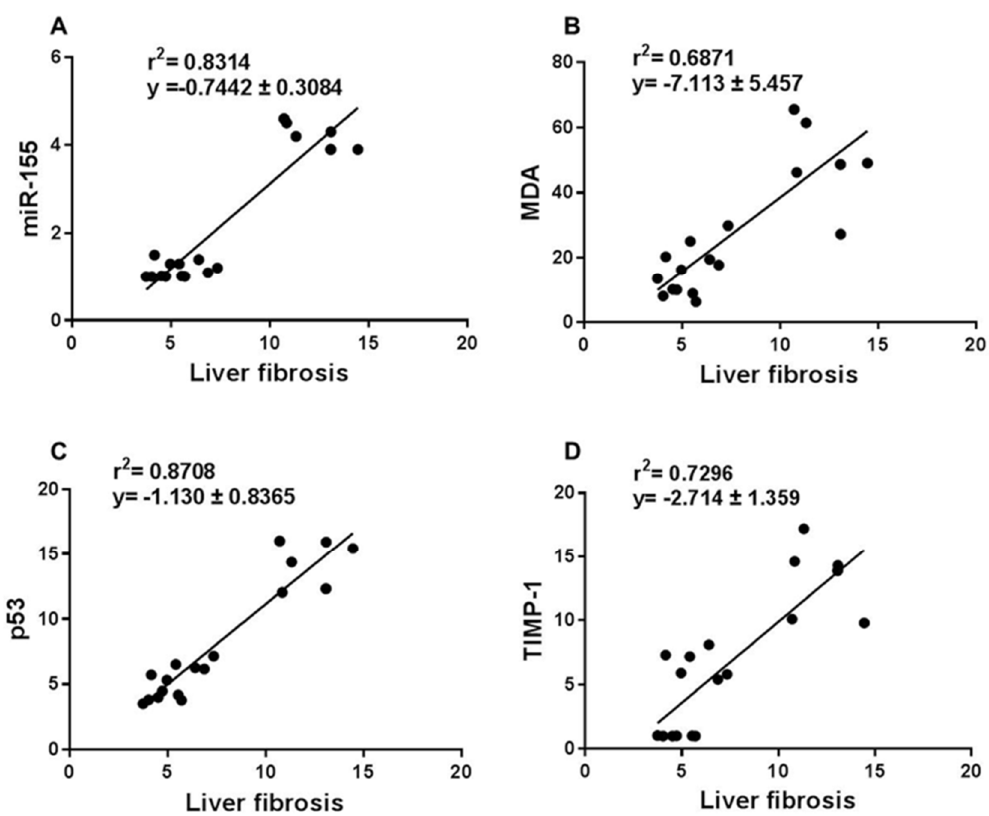
Figure 4. Correlation between liver fibrosis score and miR-155/ROS/p53 axis of fibrosis. Across all groups of rats, the above parameters were measured at the end of the study, at week 10, and the correlation between liver fibrosis score measured as the percentage of collagen deposition and miR- 155, MDA, p53, and TIMP − 1 are shown ( A – D ). miR-155: microRNA-155; MDA: malondialdehyde;